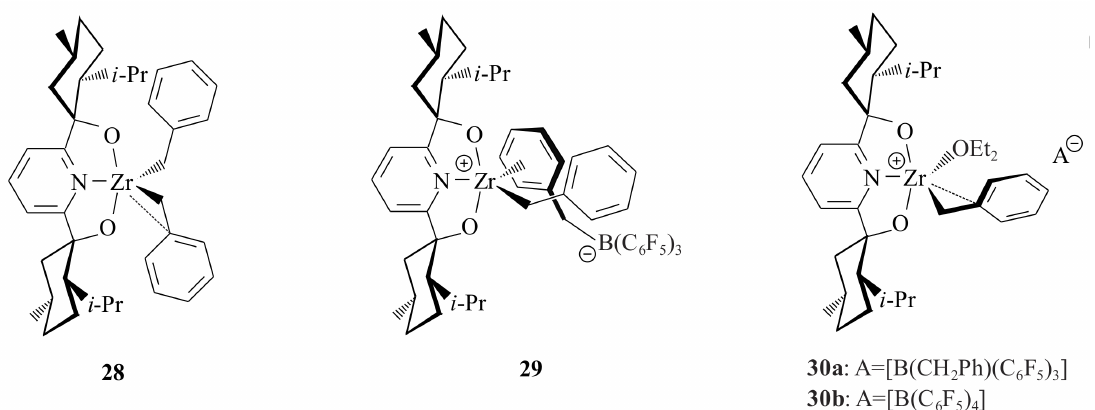
Figure 7. Neutral and cationic pyridinyl dialcoholato complexes of